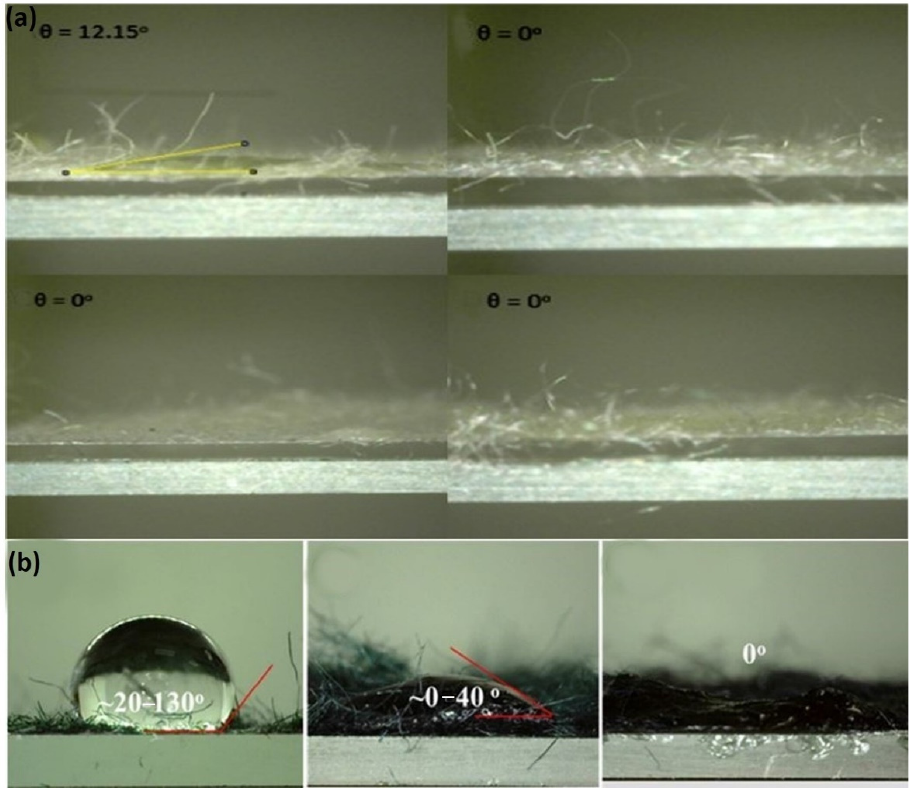
Figure 20. ( a ) DI water interaction angle with PAN-KF made with 1.5 mL AN, 10, 20, 30, and 40